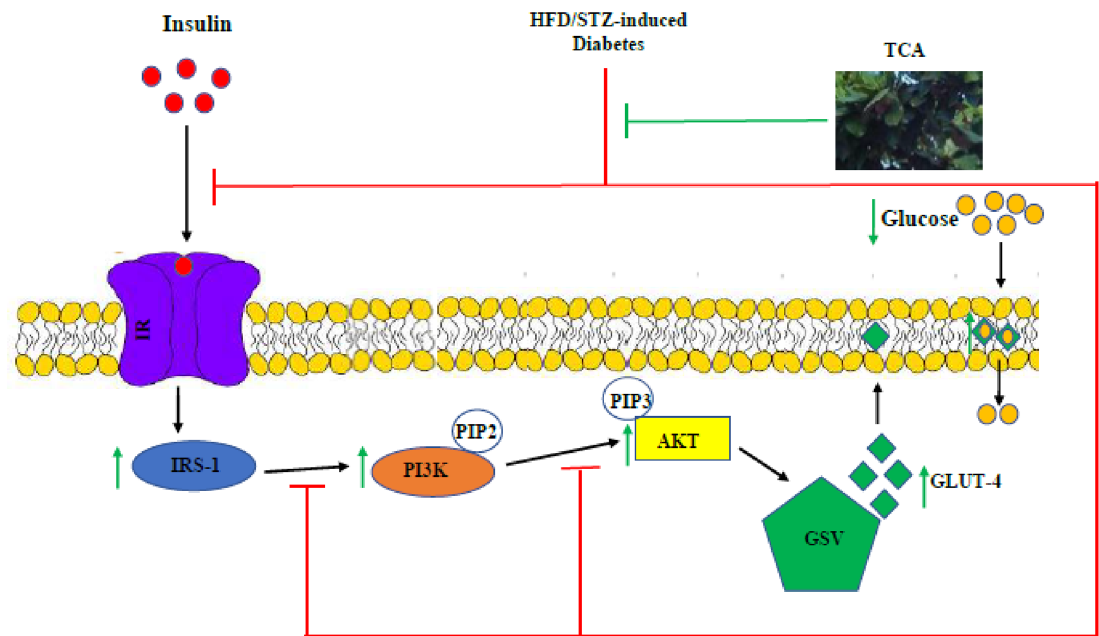
Figure 9. Proposed antidiabetic molecular mechanism of T. catappa aqueous extract in HFD/STZ-induced diabetic rats. IR: insulin receptor, IRS-1: insulin receptor substrate 1, PI3K: phosphatidylinositol 3-kinase, PIP2: phosphatidylinositol-4,5-bisphosphate, PIP3: phosphatidylinositol-3,4,5-bisphosphate, AKT: protein kinase B, GSV: GLUT-4 storage vesicle and GLUT-4: glucose transporter isoform